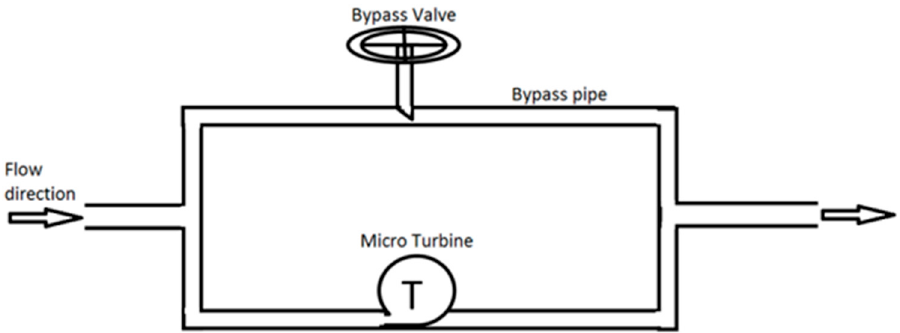
Figure 1. Micro turbine/bypass valve combination.